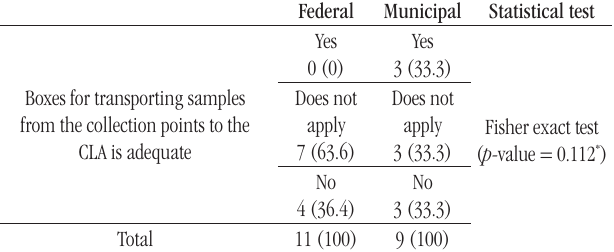
taBLE 3 − Number of federal and municipal CLA that have adequate shipping boxes